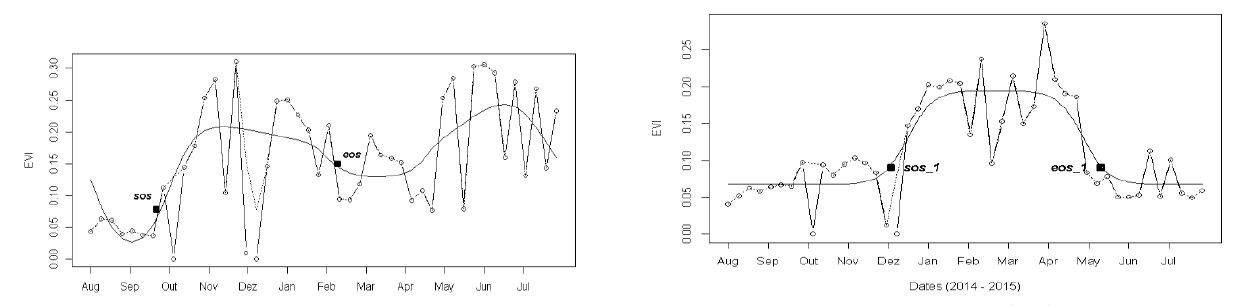
Figure 5. Time series EVI spectral profile for a semi-perennial crop sample of